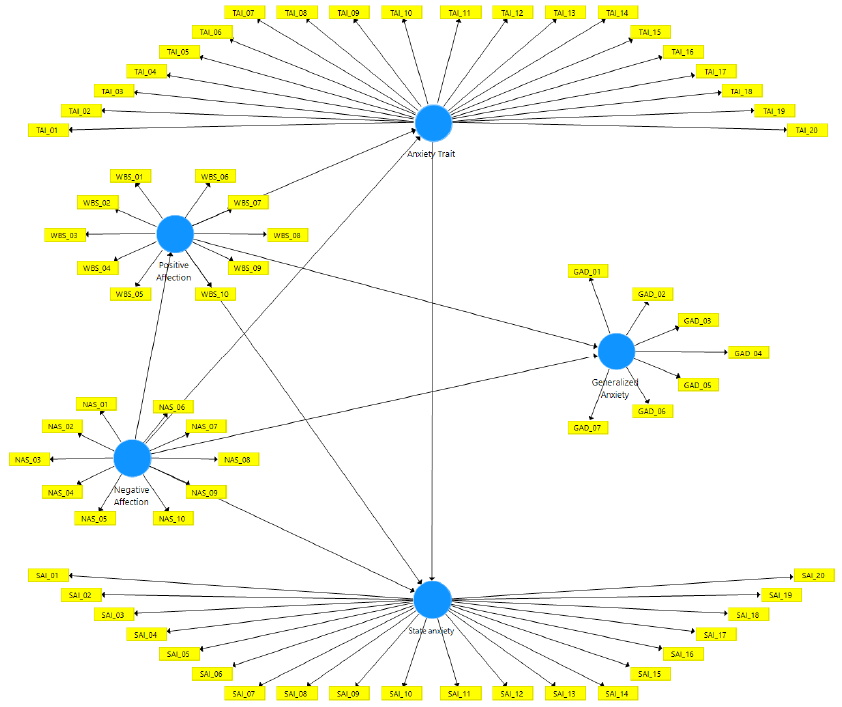
Figure 1. Initial model of the dimensions of the PANAS-GAD-7-IDATE scales. Source: Data research and SmartPLS ® software, v. 3.3.2 [44].